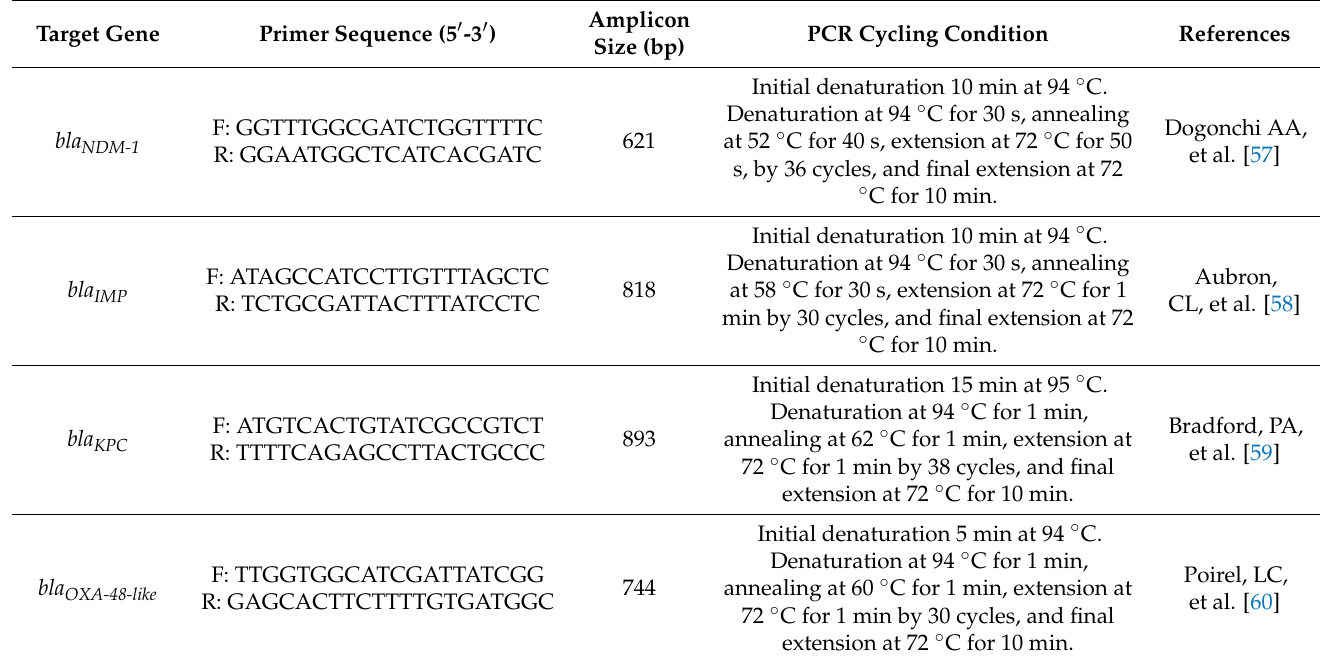
Table 2. Primer sequences of target carbapenems genes and their respective amplicon sizes and PCR cycling